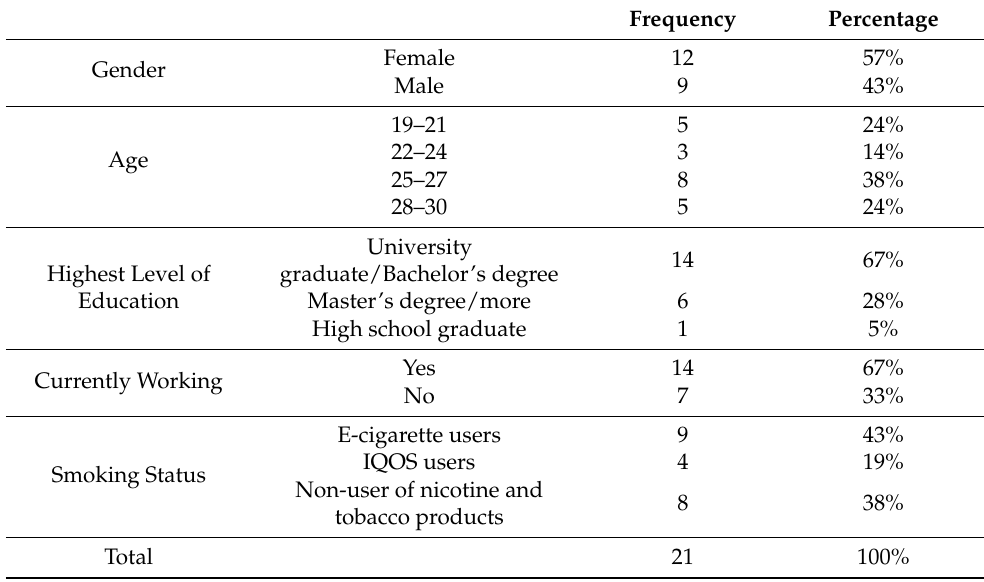
Table 1. Characteristics of interview